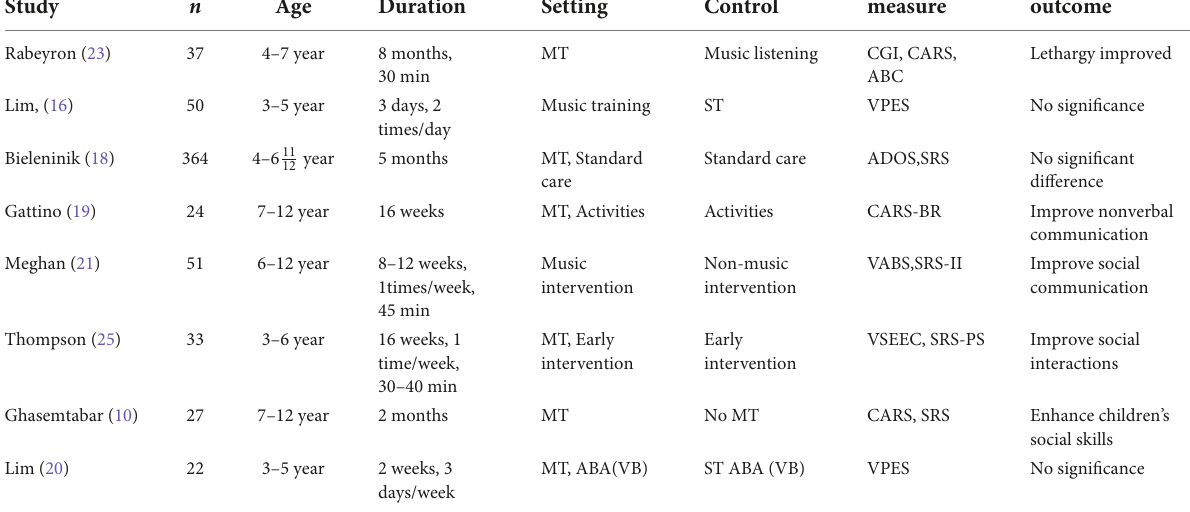
TABLE 2 Study characteristics meeting inclusion